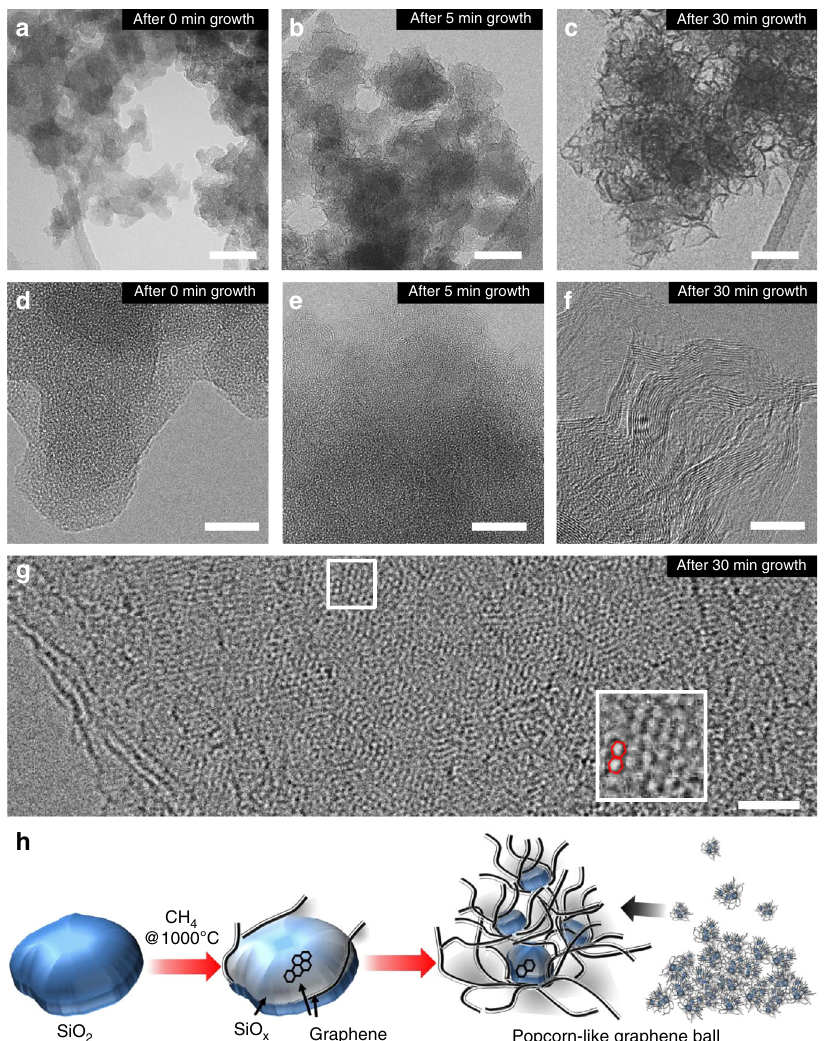
Fig. 1 Graphene growth from SiO 2 nanoparticles. a – c TEM characterization a before CVD growth, b after 5 min growth, and c after 30 min growth (scale bars, 50 nm). d – f Their respective magni fi ed images (scale bars, 10 nm). g Higher magni fi cation image of graphene after 30 min growth and its atom-level view from the white box (inset) (scale bar, 2 nm). h Graphical illustration of popcorn-like graphene growth from SiO 2